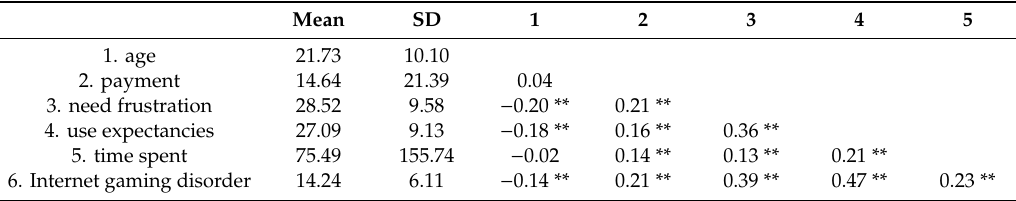
Table 1. Descriptive statistics and Pearson’s correlations matrix for study